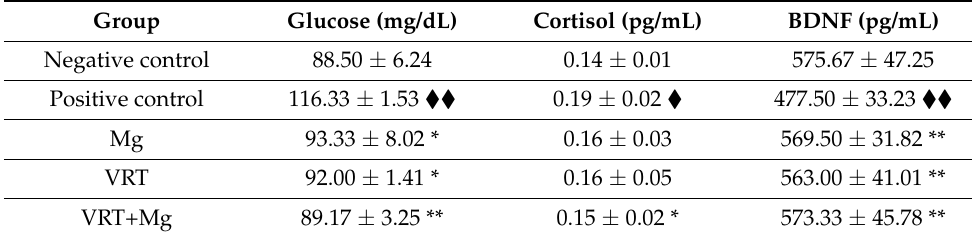
Table 1. The effects of VRT, Mg and VRT+Mg on the blood level of glucose, cortisol and BDNF in treadmill test in rats. Each point represents the mean ± S.D. of the average values for 6 animals per group. The values of the coefficient (cid:7)(cid:7) p < 0.01, (cid:7) p < 0.05 were considered statistically signif- icant versus negative control; ** p < 0.01, * p < 0.05 were considered statistically significant versus positive